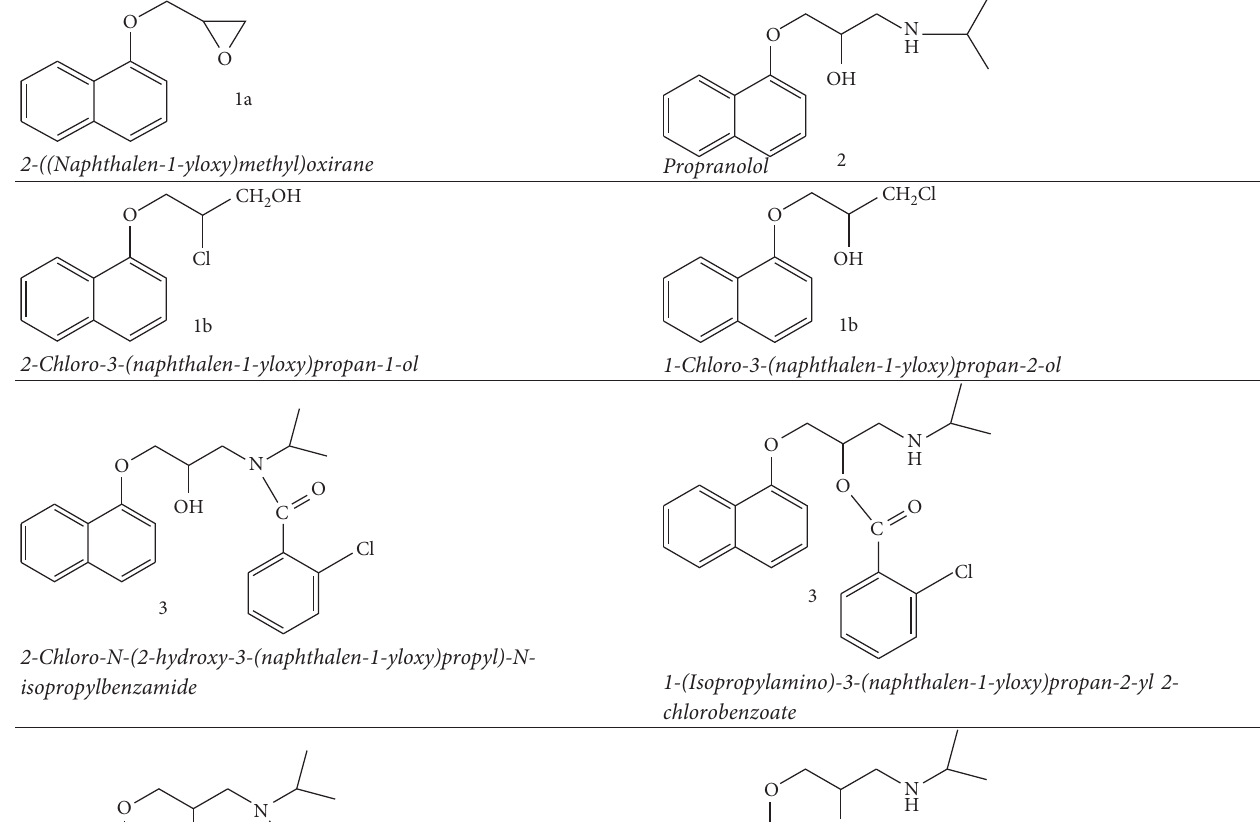
Table 1: Summary of propranolol